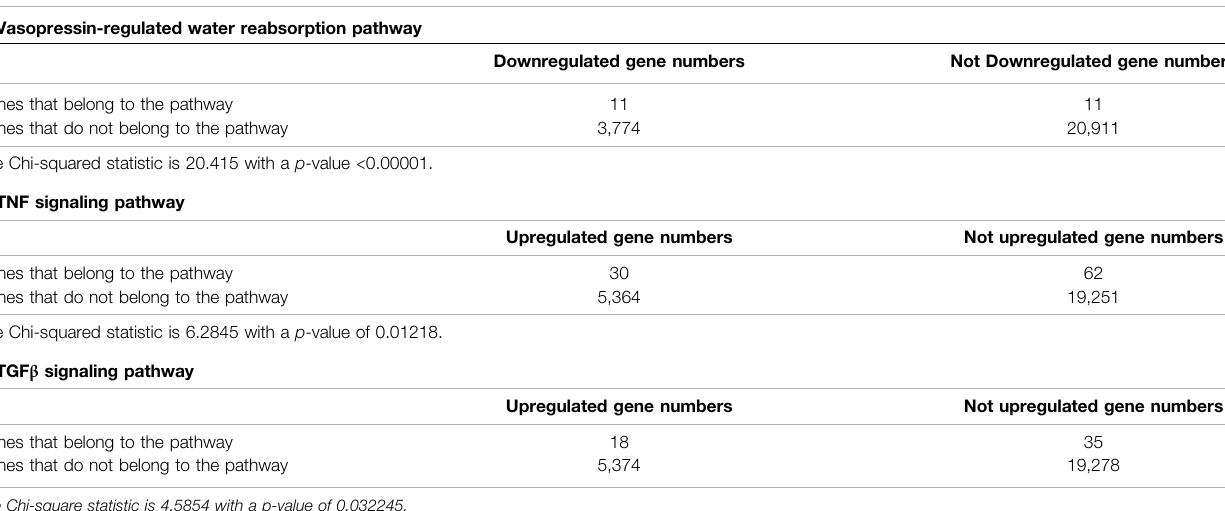
aforementioned three KEGG pathways in the glucocorticoid receptor knockdown cells ( Table 4 ).